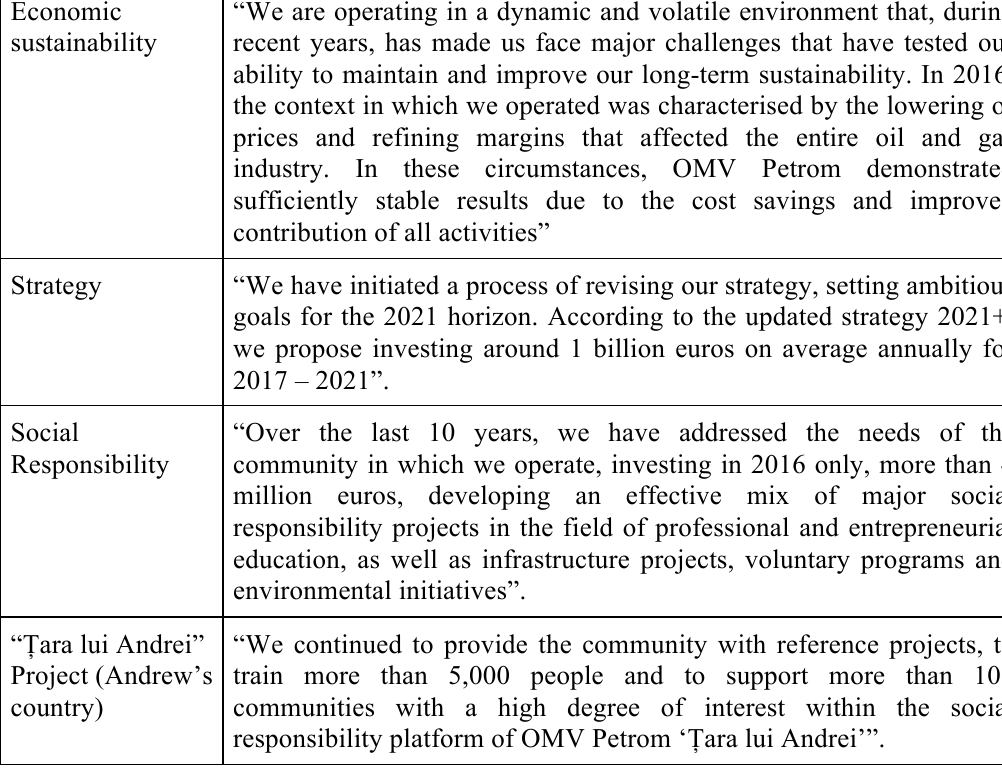
Table 4: OMV Petrom Principles and Projects by CEO Mariana Gheorghe